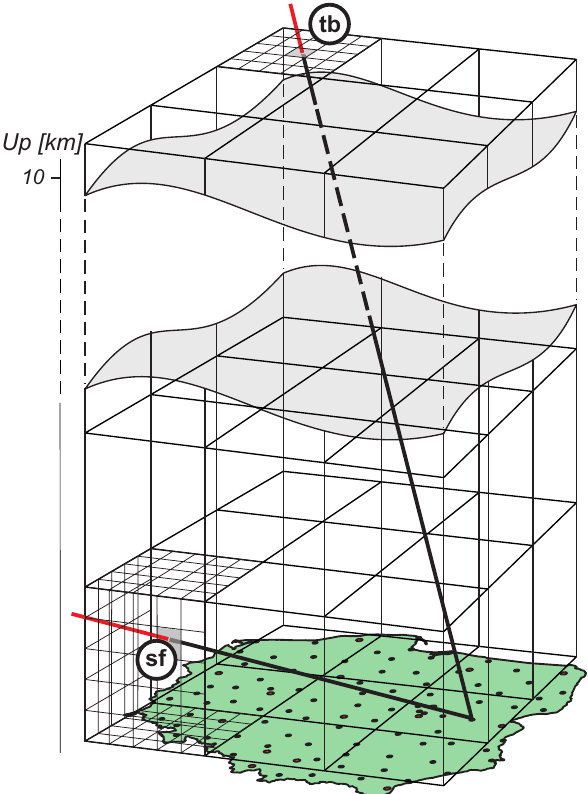
Fig. 10. The ray path in consecutive voxels. Two cases are con- sidered, the first when the ray is coming out of the model’s side face (sf), and the second, when ray is coming out of the model top boundary